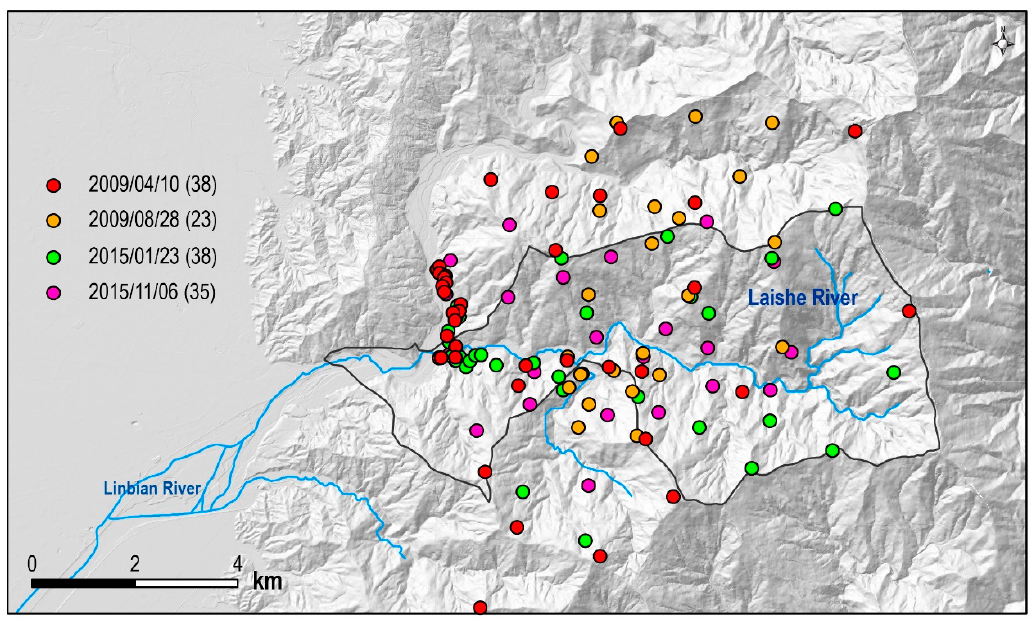
Figure 2. Distribution of ground control points (GCPs) of digital elevation models (DEMs). The dots denote the sampling point in this study and the colors denote various missions of the surveys.